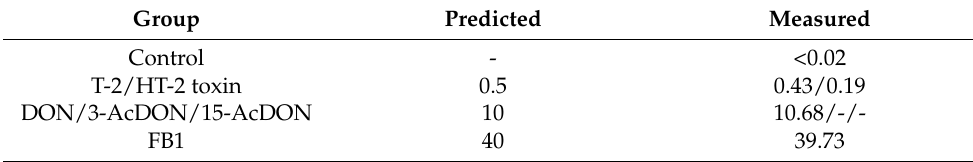
Table 1. Predicted and measured mycotoxin concentrations in the diets (mg/kg feed). Group